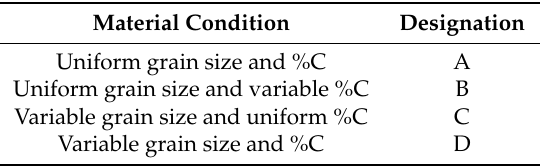
Table 2. Designation of material condition and their corresponding parameters employed in the simulation.